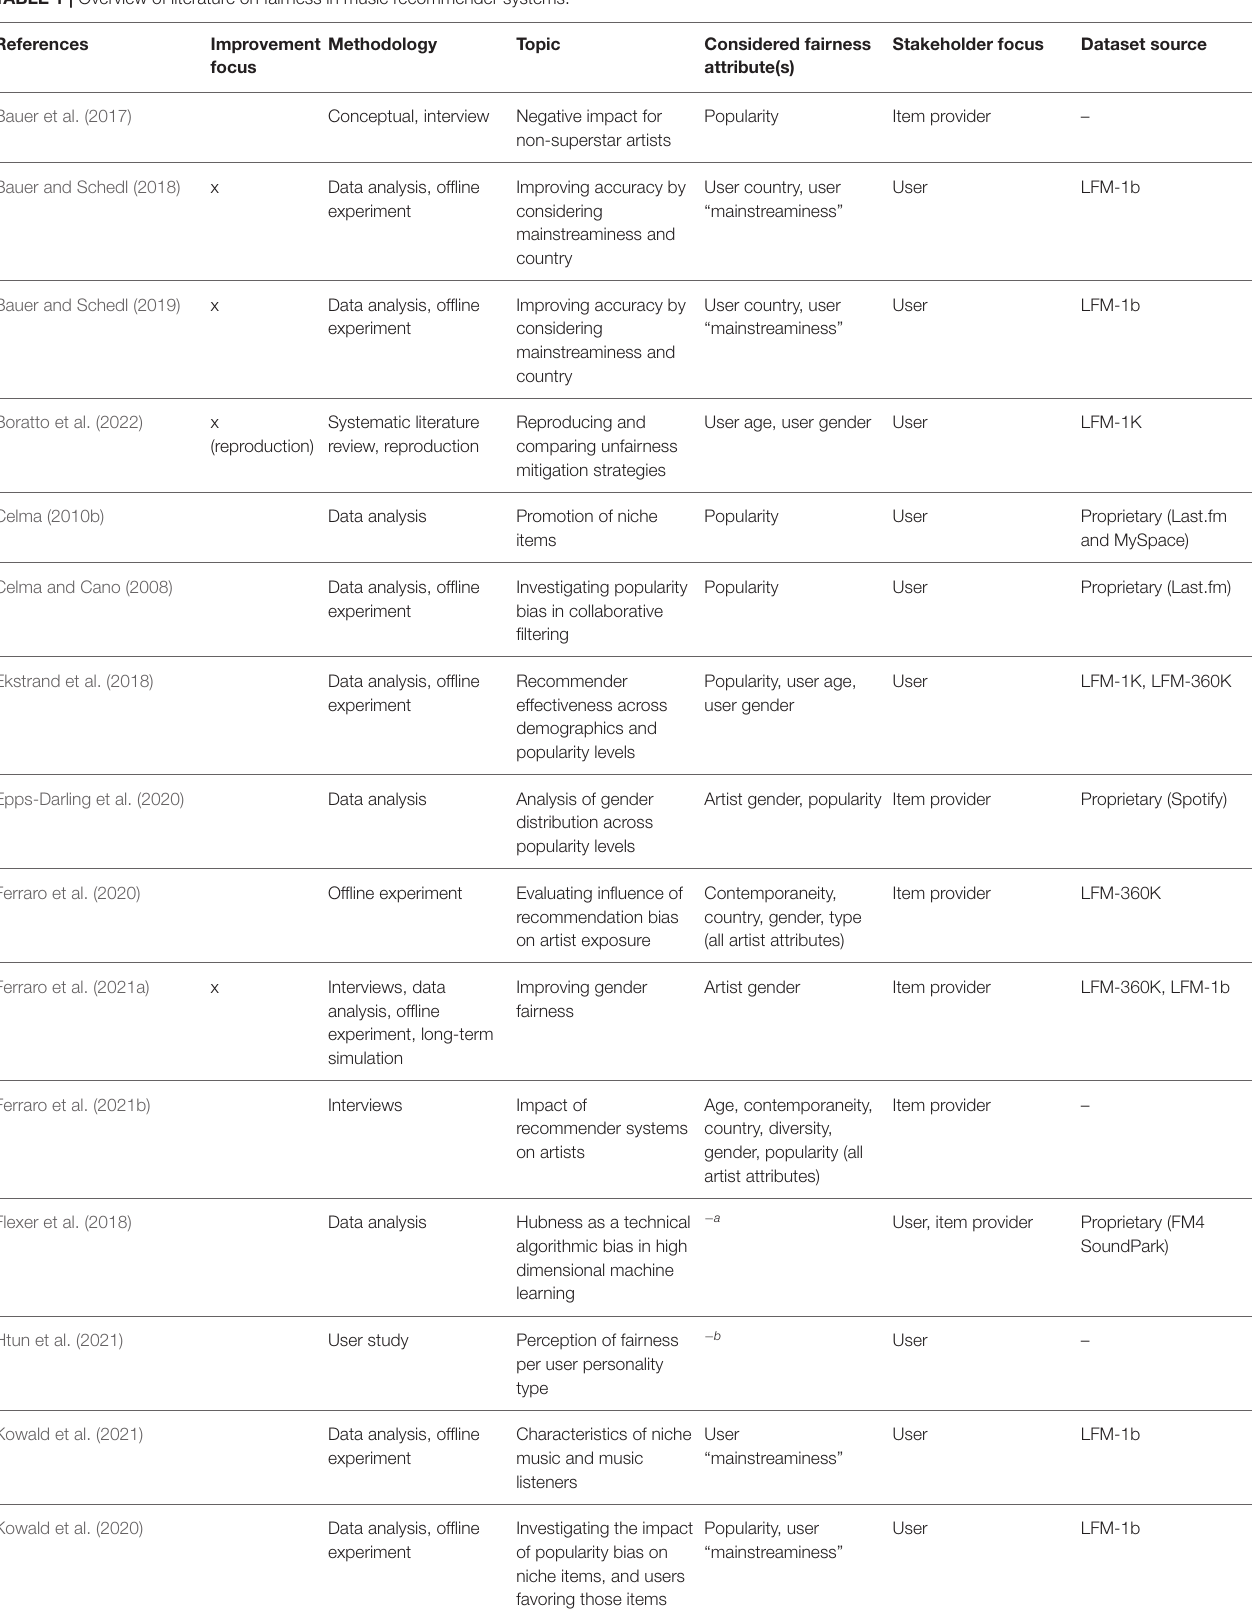
TABLE 1 | Overview of literature on fairness in music recommender